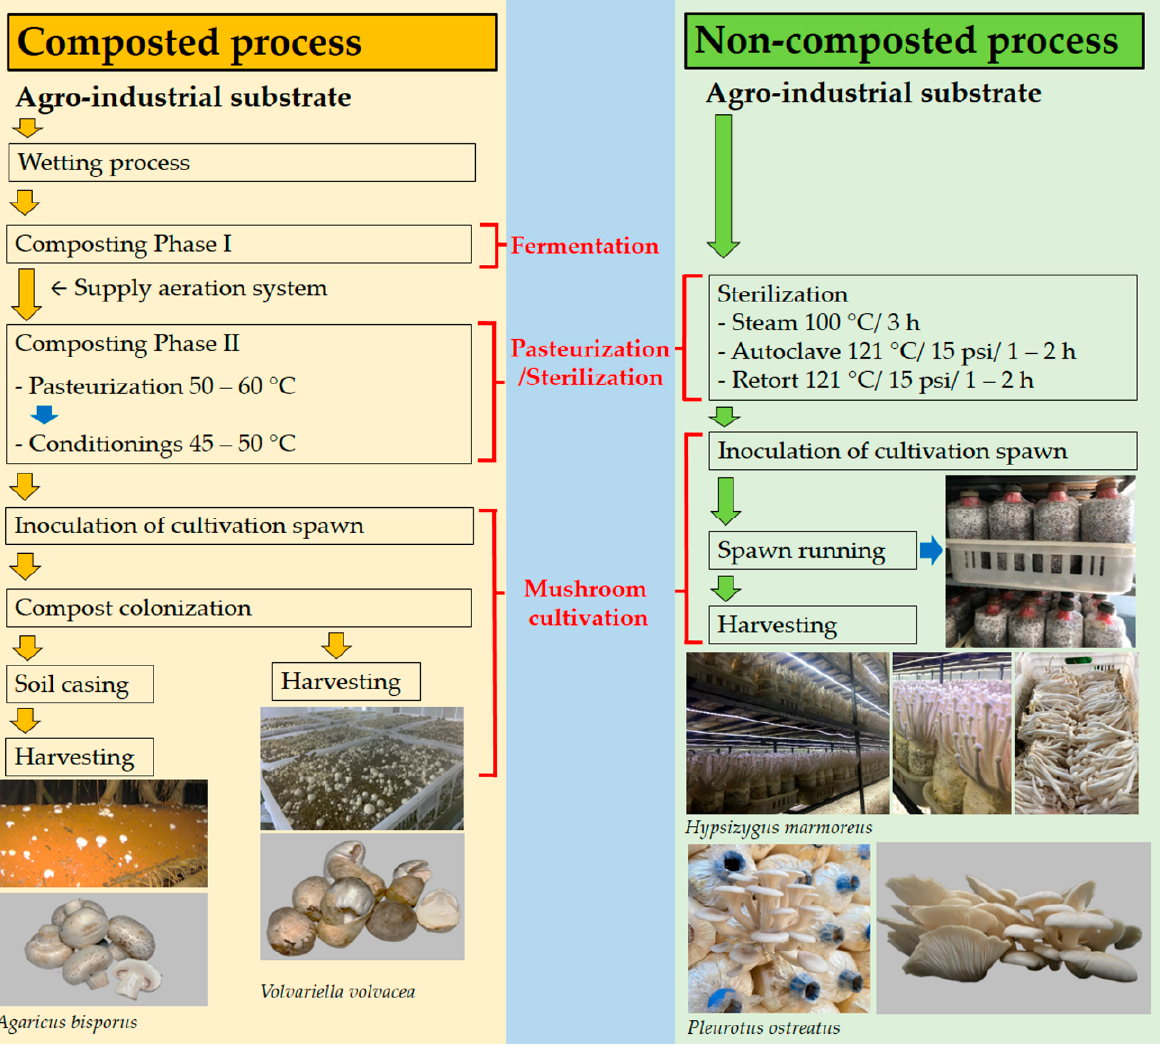
Figure 2. Overview of mushroom cultivation methods for composted and non-composted process. Photo credit: Suwannarach, N.